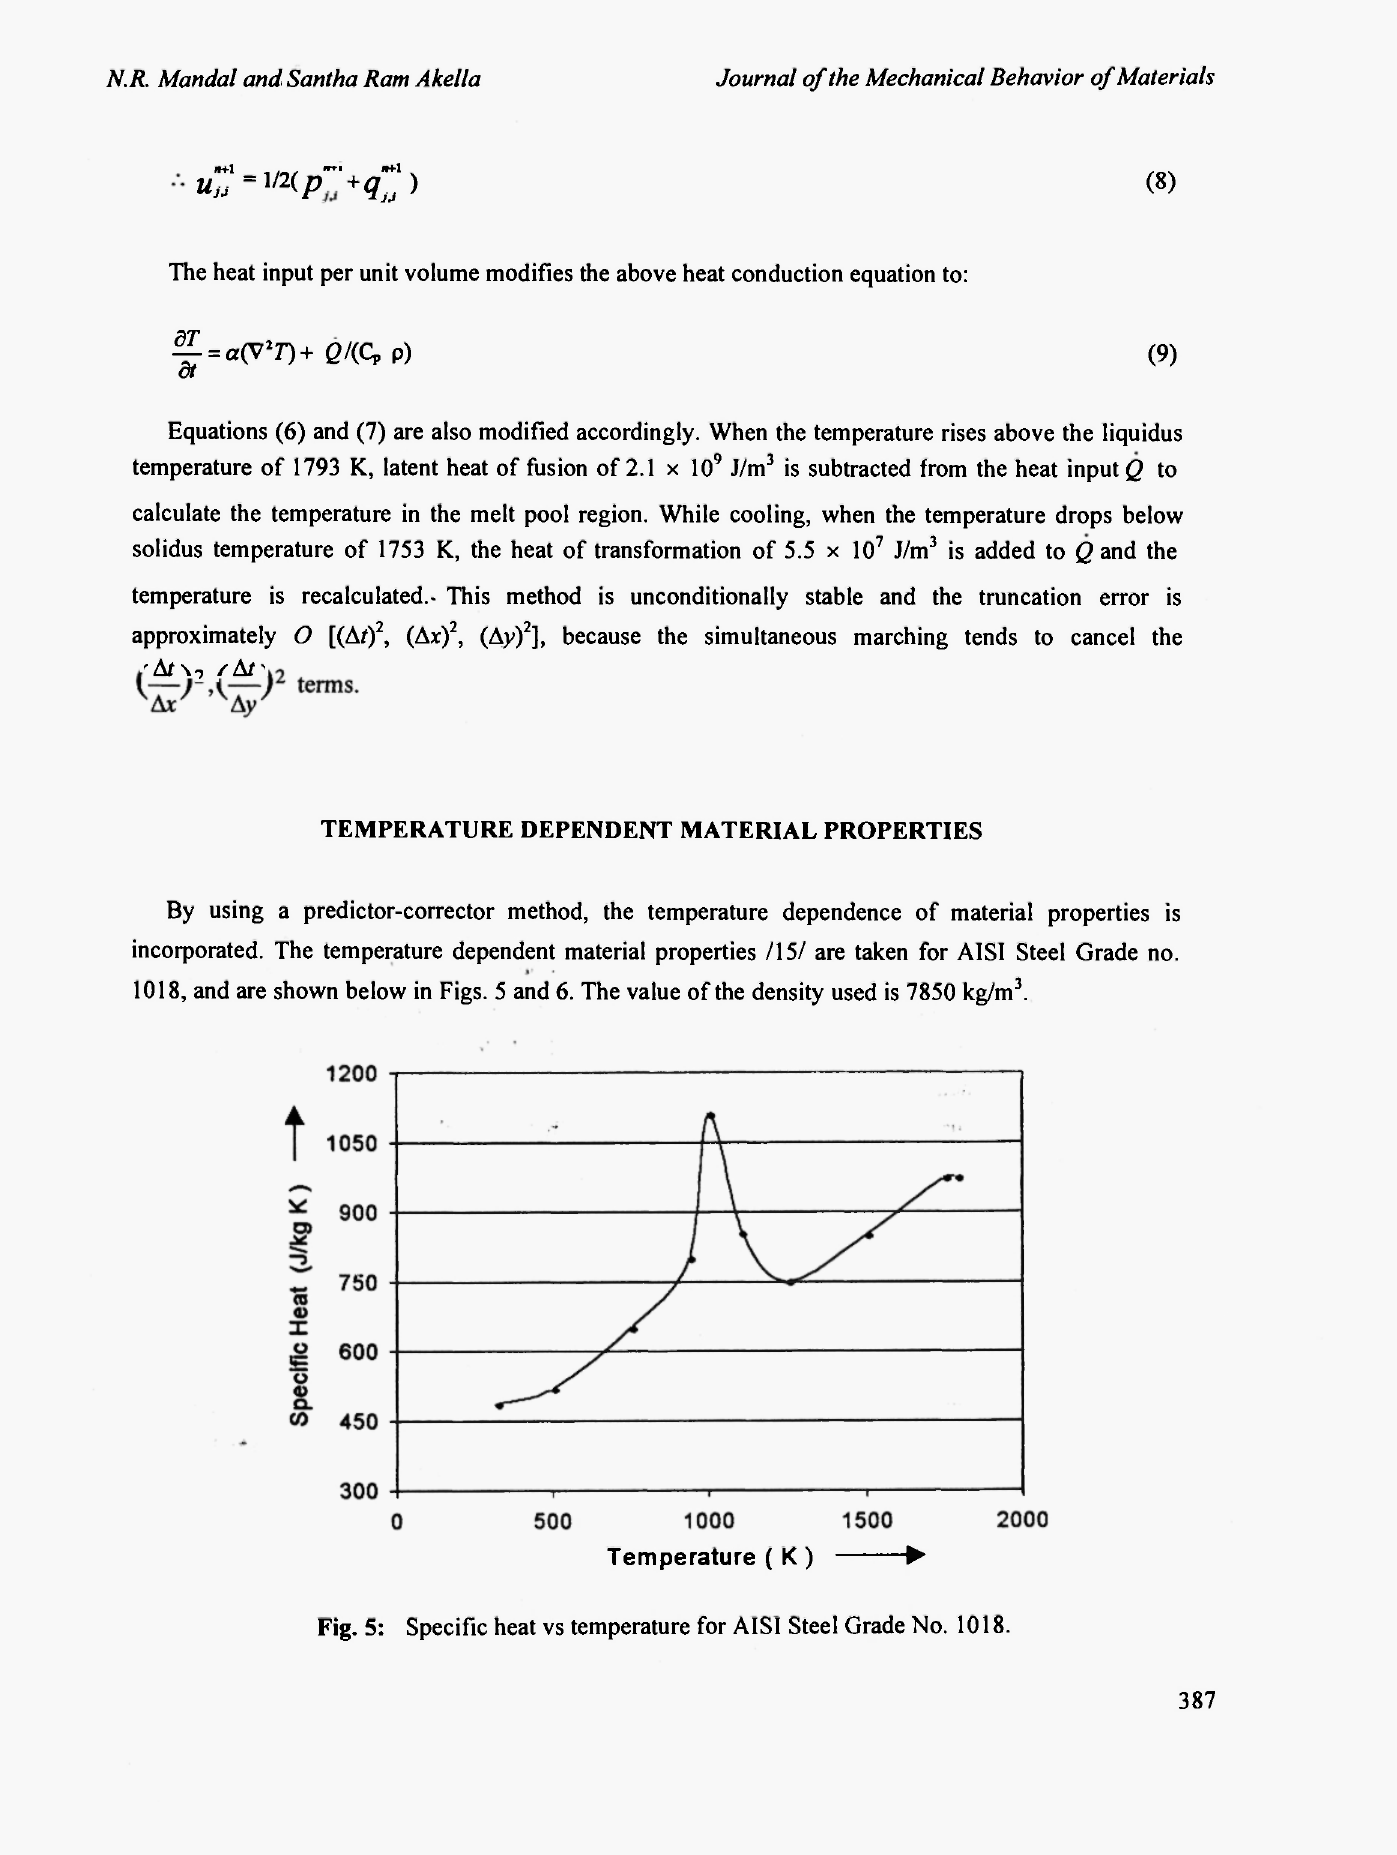
Fig. 5: Specific heat vs temperature for AISI Steel Grade No.